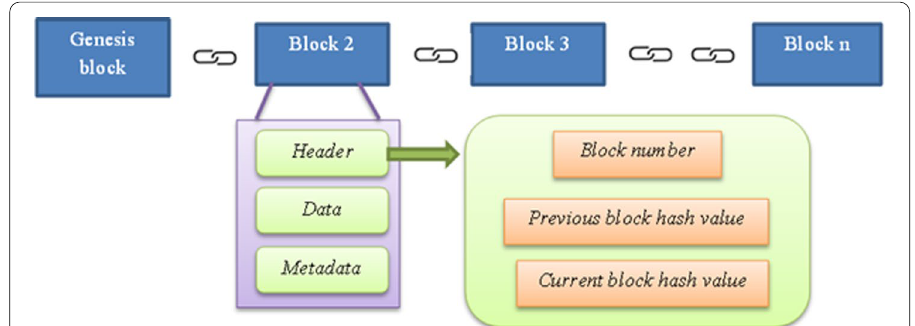
Fig. 6 Block structure for hyperledger blockchain used in BC-HyIDS. Hyperledger blockchain along with block structure is shown. First block of this blockchain is genesis block. Each block consists of header,